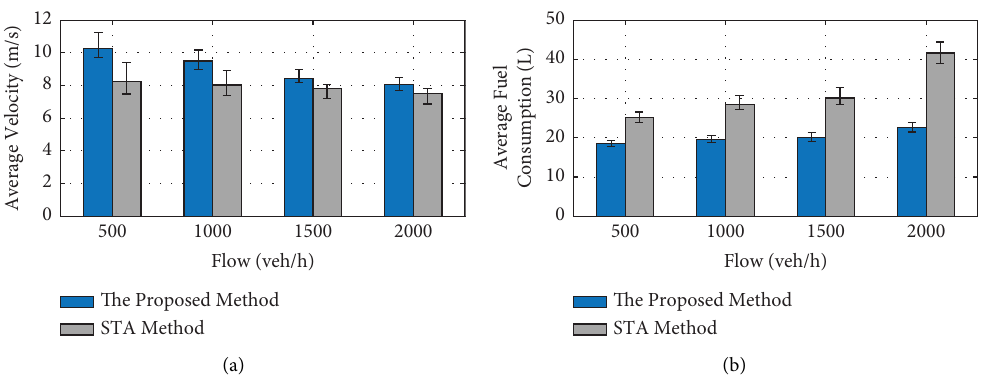
Figure 6: Comparison results of two methods. (a) Comparison results of average velocity. (b) Comparison results of average fuel consumption.